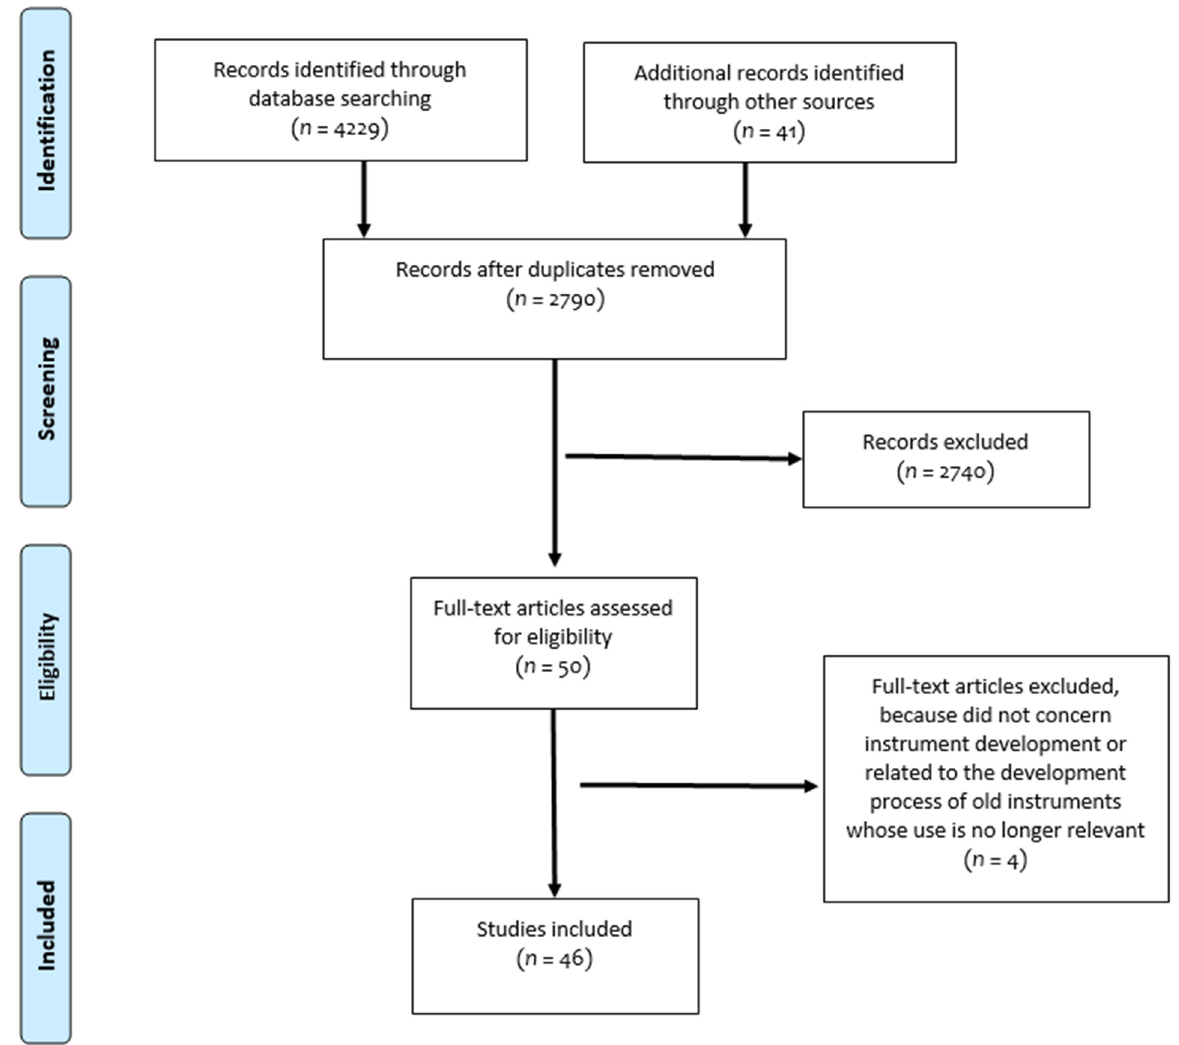
Figure 1. PRISMA flowchart, June 18, 2020.